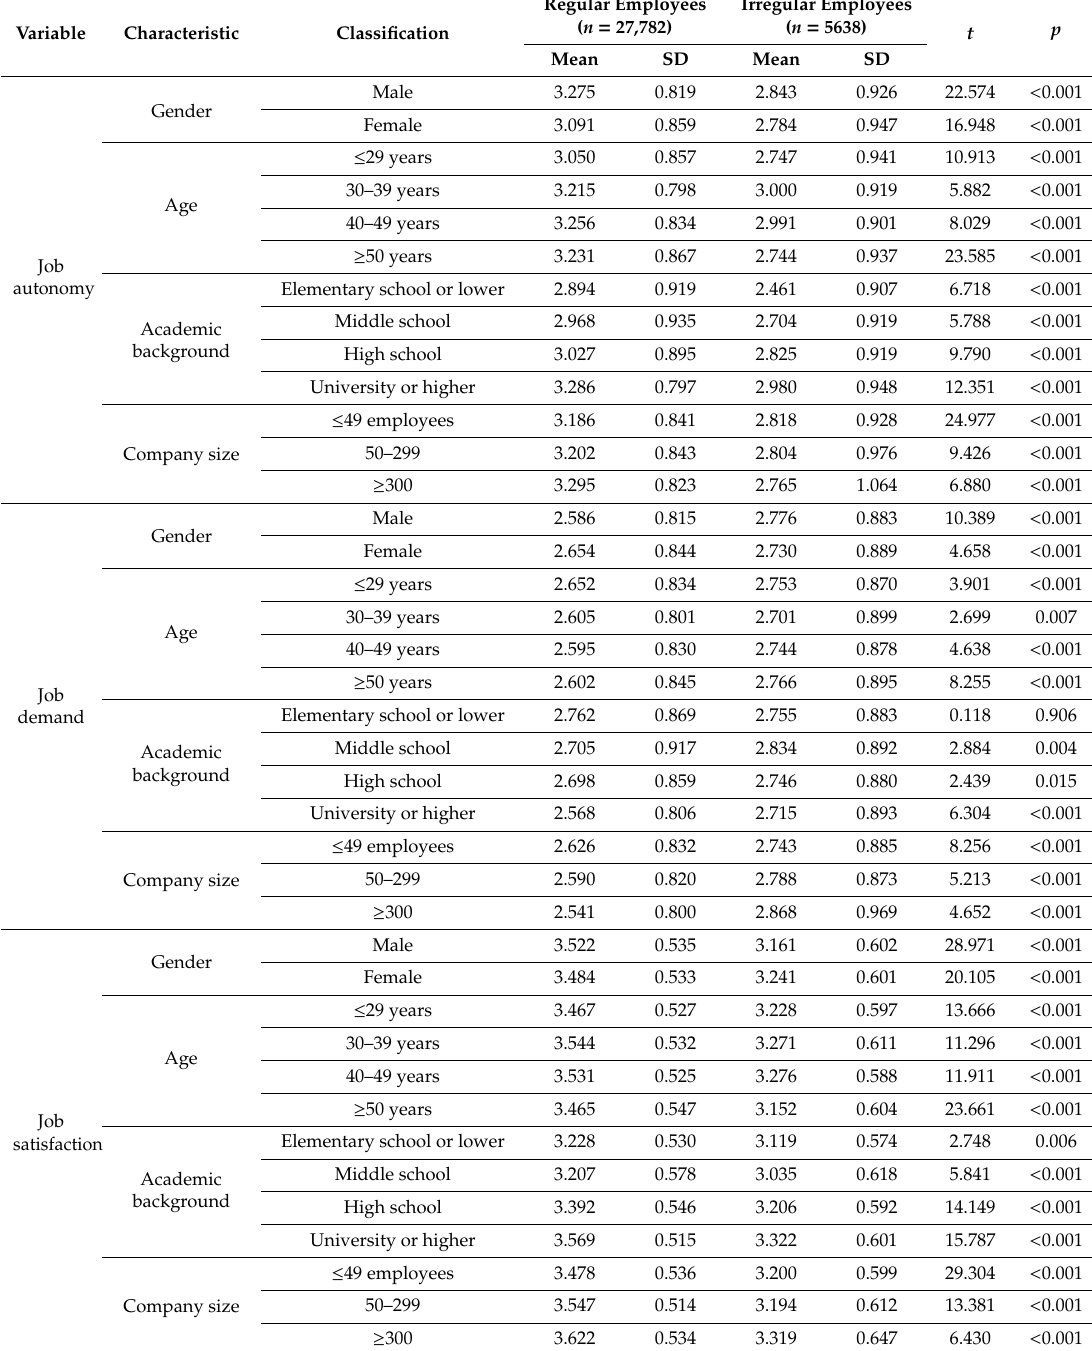
Table 3. Job stress and satisfaction in regular and irregular employees according to demographic variables.